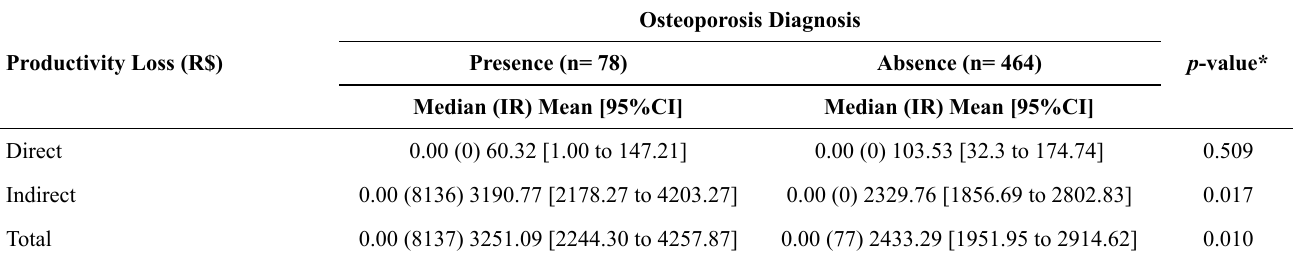
Table 3. Health-related productivity loss according to osteoporosis diagnosis (n= 78; Presidente Prudente,